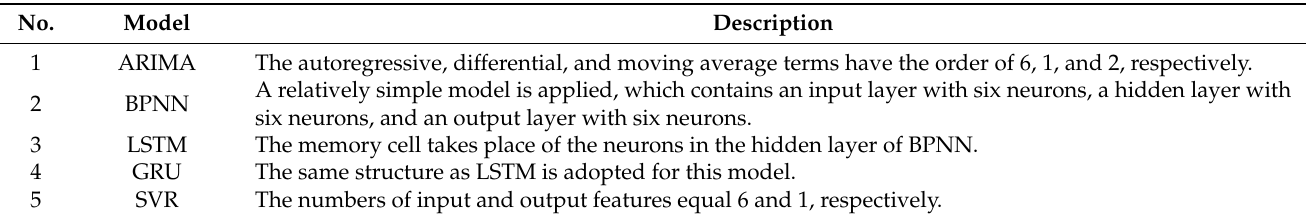
Table 2. Statistical models employed for short-term forecasting of tropical storms. No.